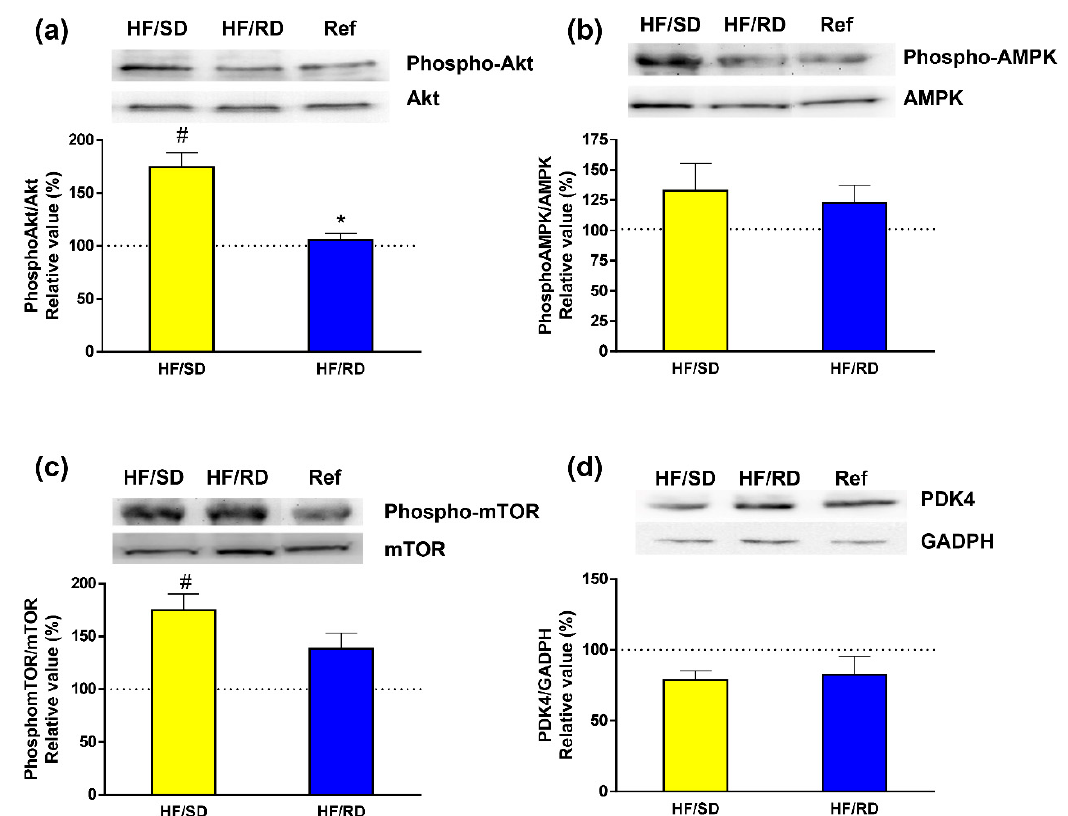
Figure 6. Signaling pathways involved in the regulation of liver metabolism. The phosphorylation of key kinases has been analyzed by western blot. ( a ) PKB–Akt, ( b ) AMPK, ( c ) mTOR and ( d ) PDK4. Results have been referred to control rats (100% value). Results are mean ± SEM ( n = 6 animals per group). * p < 0.05 compared to the HF–SD group; # p < 0.05 compared to the reference group.